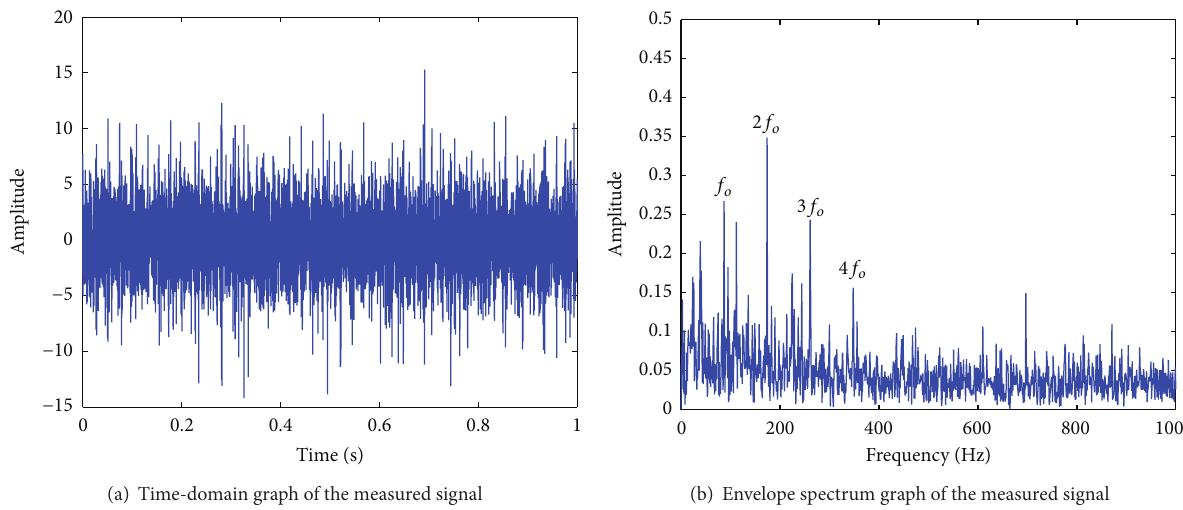
Figure 7: The time-frequency diagram of the measured signal.